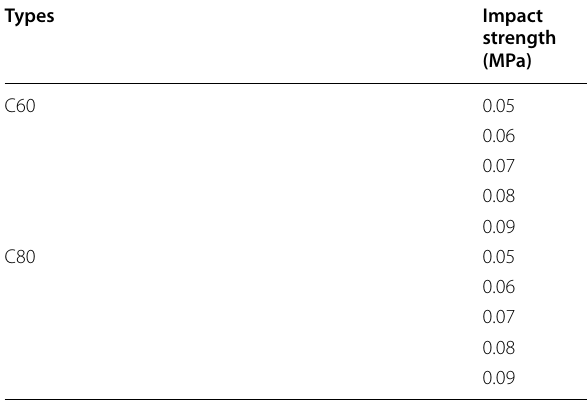
Table 4 SHPB dynamic splitting and pulling